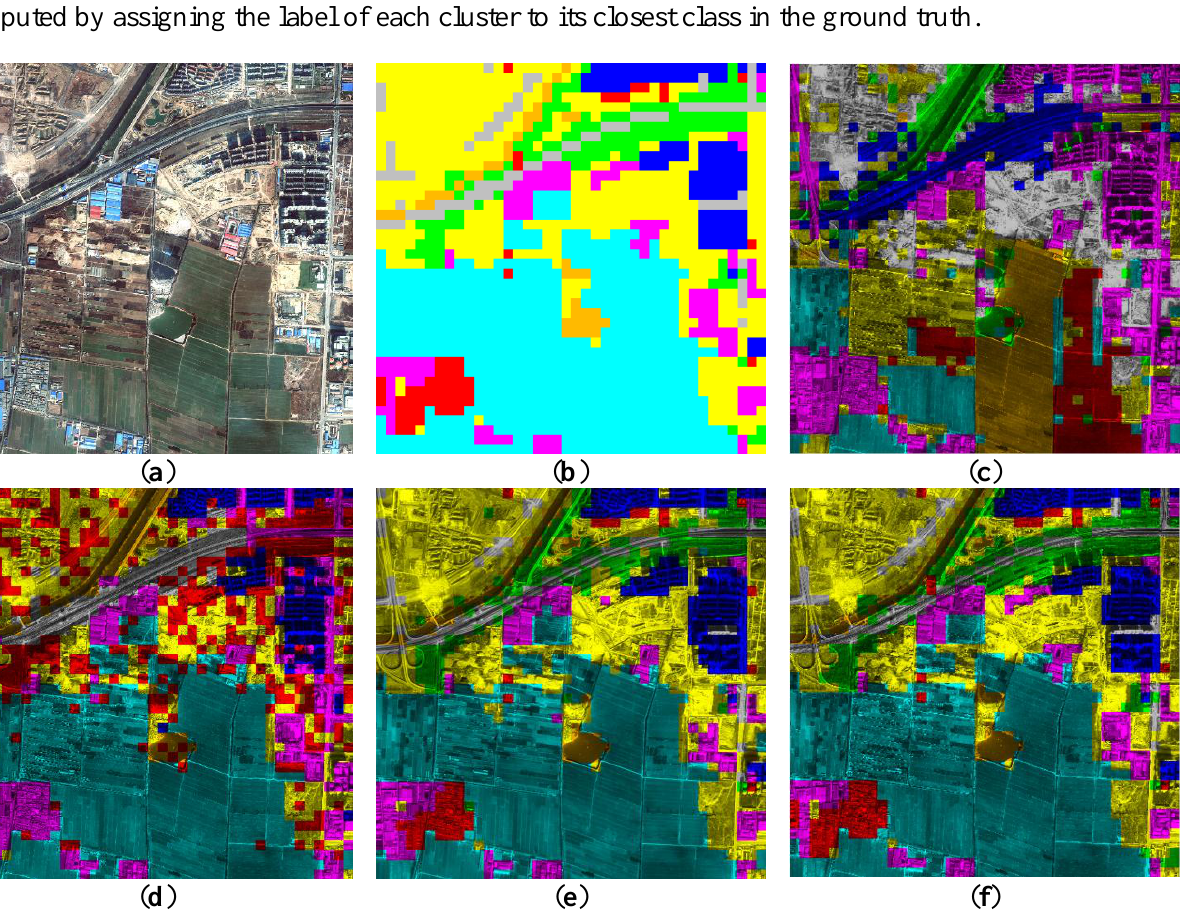
Figure 16. Comparison of the results of different methods for the annotation of a GeoEye-1 image of Beijing (refer to the text for more details): ( a ) original image; ( b ) human-labeled ground truth; ( c ) annotated via spectral clustering (SC) [45] (35.8%); ( d ) annotated via S 3 C [58]. (semi-supervised) (61.8%); ( e ) annotated via M 3 DA-RF [17] (fully supervised) (91.6%); and ( f ) annotated via AASC